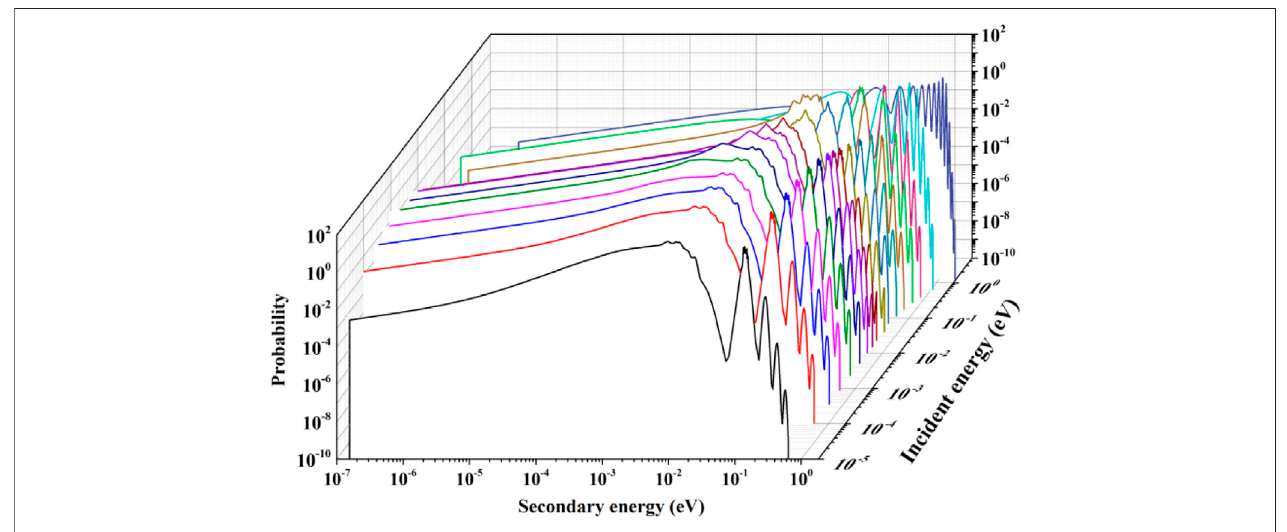
FIGURE 1 | Secondary energy distribution of the inelastic scattering from ZrH x .